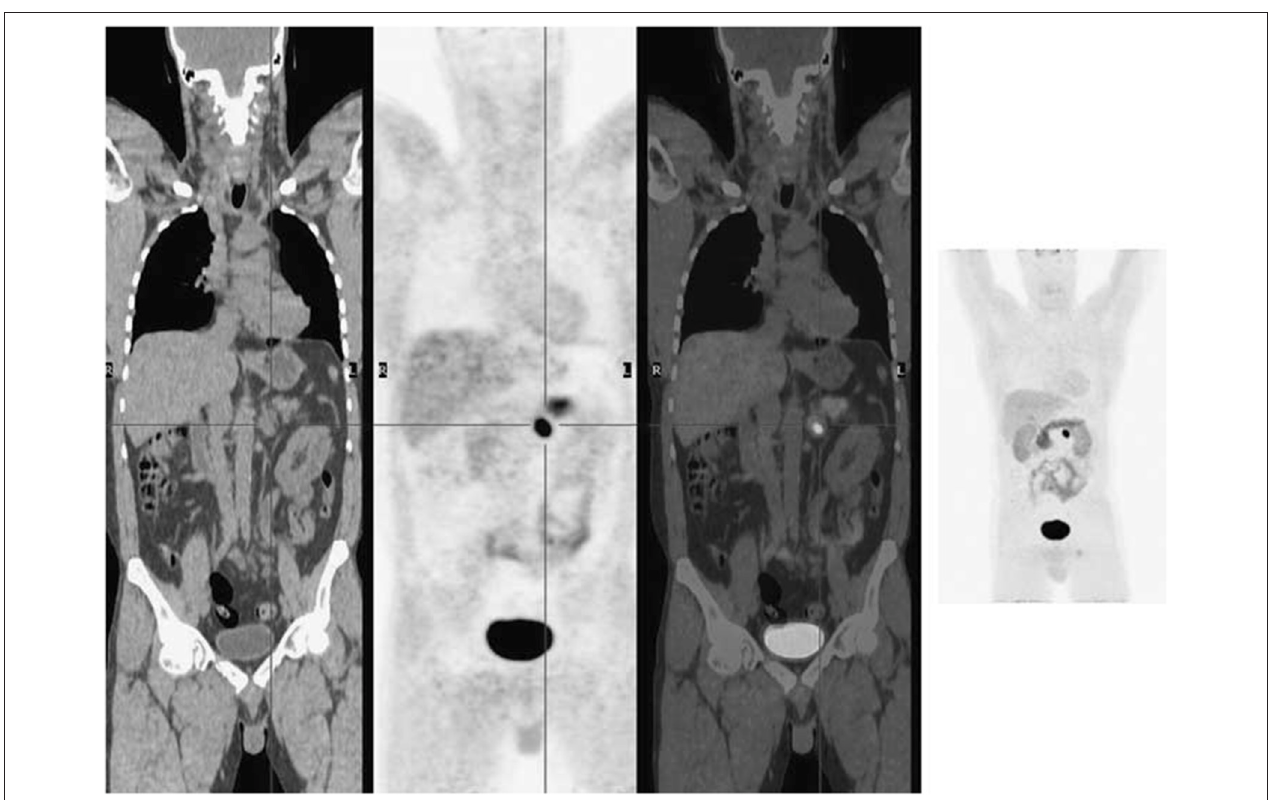
FIGURE 6 | 18 F-FDOPA PET imaging illustrated a solitary left phaeochromocytoma. Left, coronal CT image; mid left, coronal PET image; mid right, coronal fused PET/CT image; right, maximum intensity projection image. This figure is reproduced with permission from Wong et al. (2011), Figure 9 © by the Society of Journal of Nuclear Medicine Imaging,